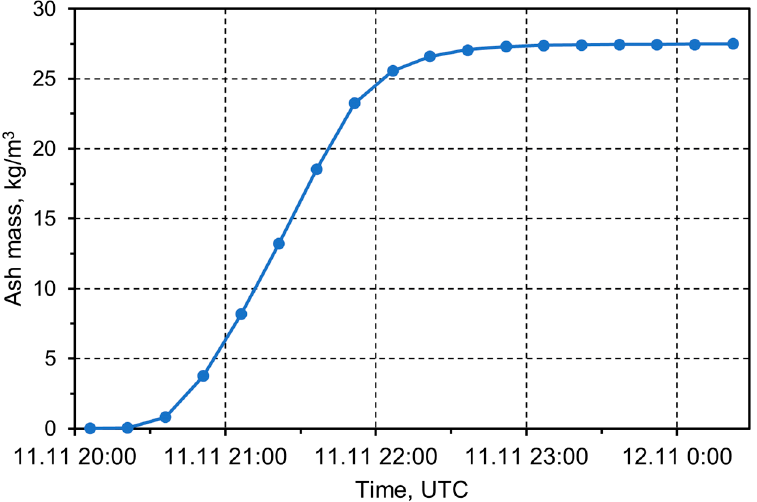
Figure 11. The distribution of the fallen ash mass over the time in Ust-Kamchatsk calculated through modeling.